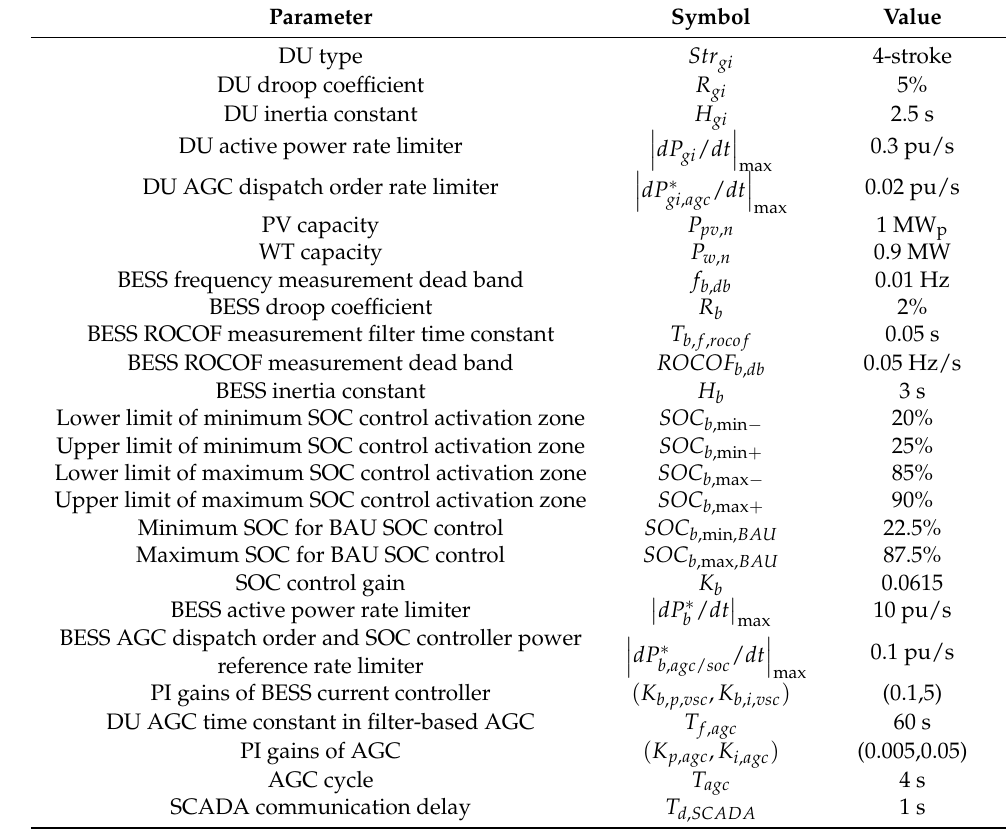
Table A2. Time-domain simulation